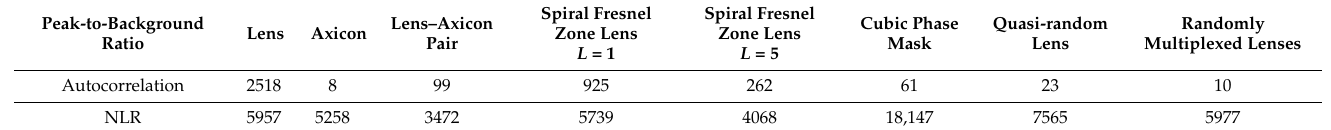
Table 1. Rounded PBR values obtained for different phase masks for autocorrelation and NLR.